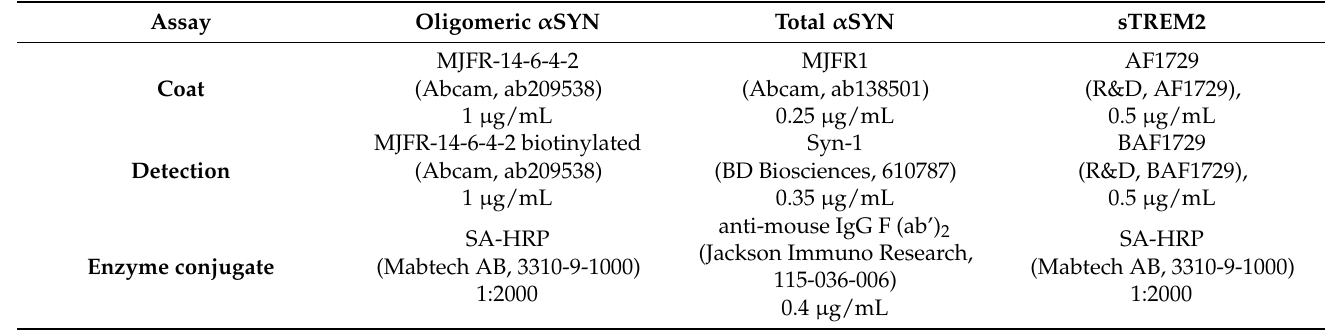
Table 1. The concentration of antibodies and enzyme conjugates used in sandwich